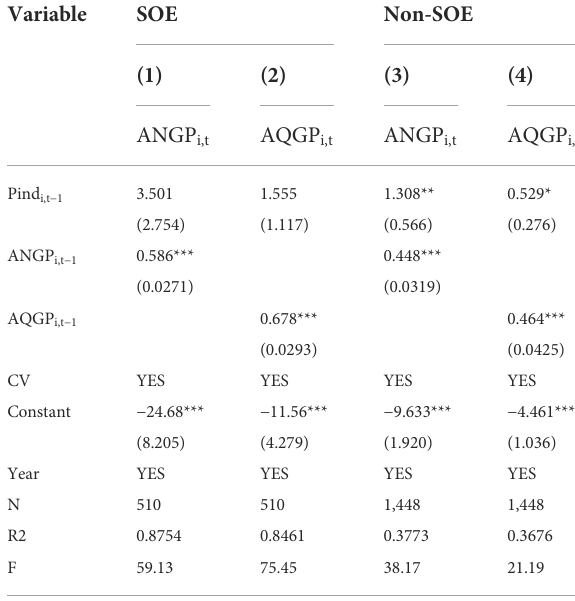
TABLE 9 Test results for the impact of the environmental administrative penalty on the GTI of heterogeneous peer